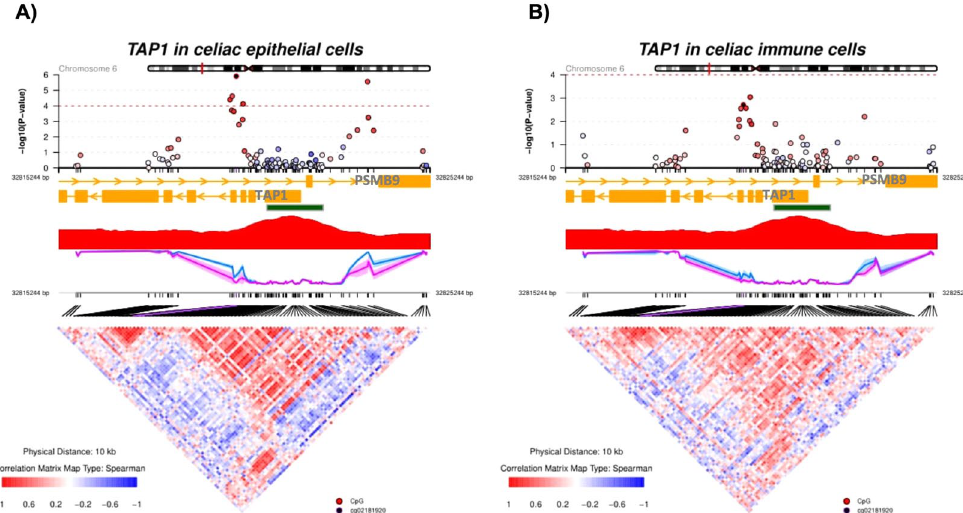
Figure 4. Methylation and comethylation profiles of the HLA-DMR close to TAP1 , in celiac epithelial ( A ) and immune ( B ) cells. The graphs at the top show the p values of the methylation differences between celiac and control cells in each CpG position. The black circle is the reference hit, and the color of the rest of the circles represents the Spearman correlation coefficient between the rest of the methylation values and the reference point, according to the color scale. The CG content is shown in red and the blue and the purple lines below represent the methylation levels in the control and the celiac patients, respectively. The squares in the correlogram at the bottom represent the pairwise correlation between CpG